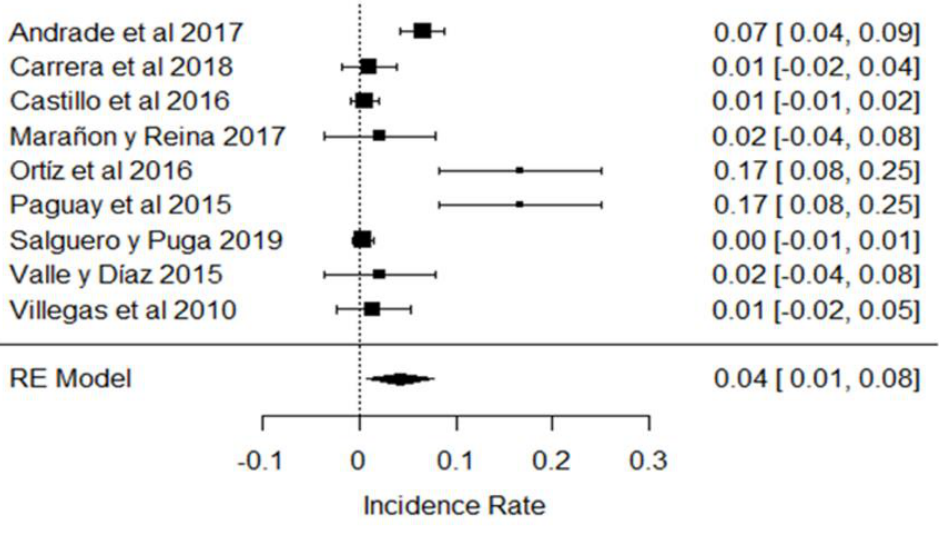
Figure 19. Forest plot of the presence of peroxides [21, 31-32, 38-39, 43-44, 79, 82].